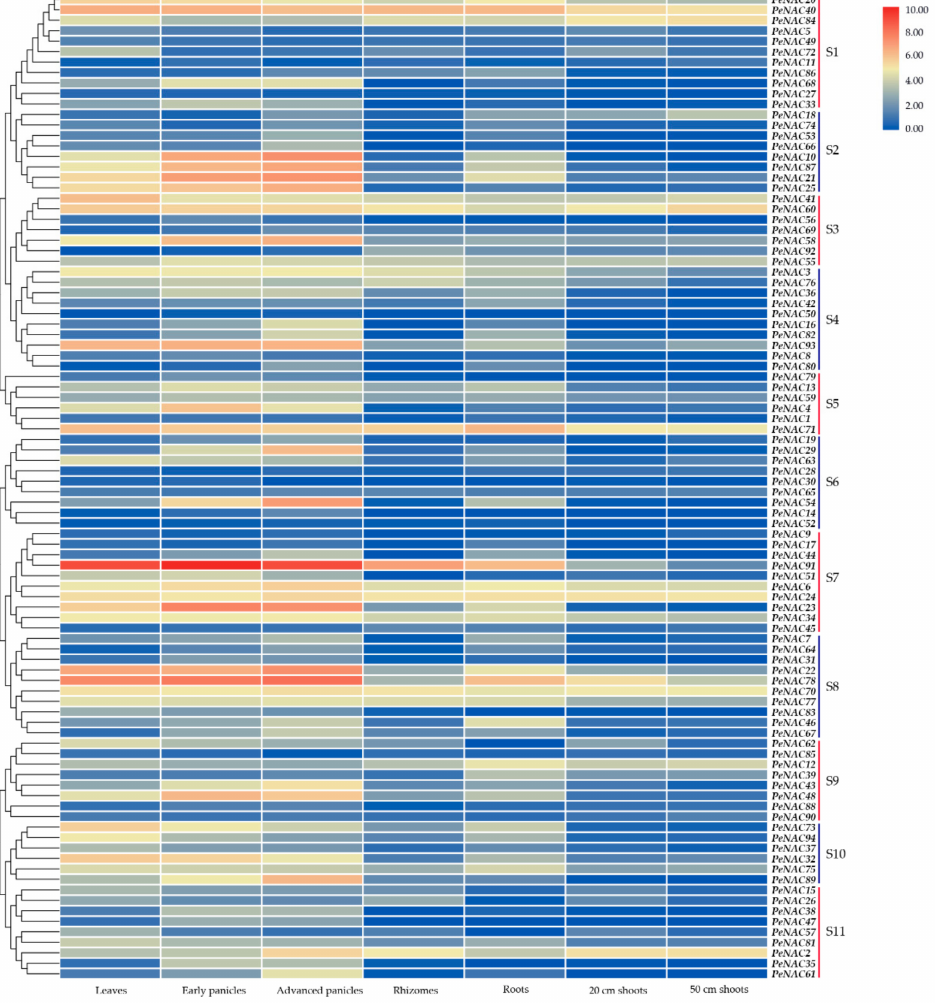
Figure 4. Expression patterns of PeNAC s in di ff erent tissues / organs of moso bamboo based on the transcriptome data. Heatmap represented for the expression of PeNAC s in leaves, early panicles, advanced panicles, rhizomes, roots, 20 cm shoots, and 50 cm shoots. Color scale represented log 2 expression values, with the color from blue to red indicating low to high expression